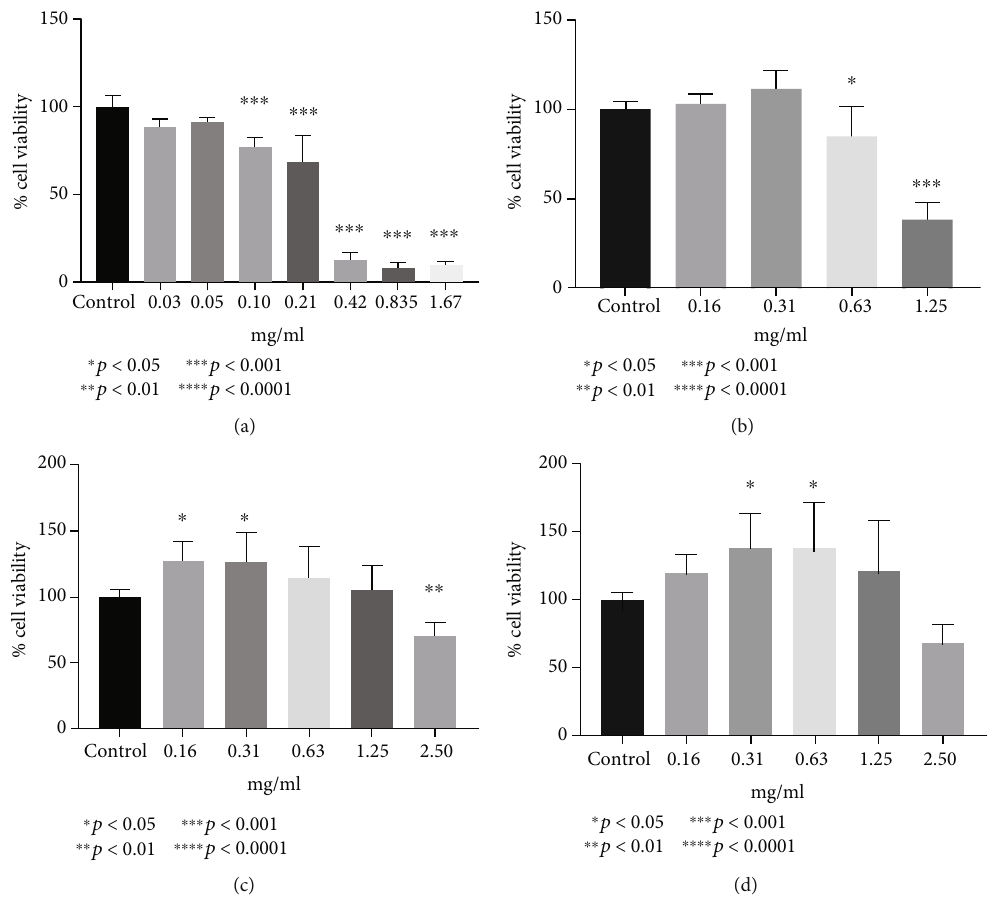
Figure 4: Percentages of CRL-2076 viability after 24 h incubation with A. paniculata extract (a), T. crispa extract (b), formulation No. 7A (c), and formulation No. 19A (d). ∗ p < 0 : 05 , ∗∗ p < 0 : 01 , ∗∗∗ p < 0 : 001 , ∗∗∗∗ p < 0 : 0001